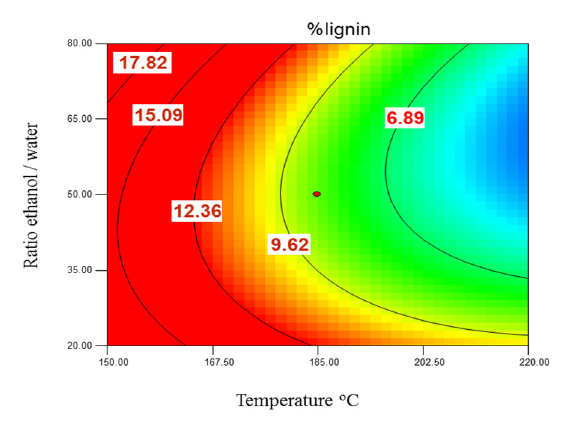
Fig. 4. Effect of temperature and ethanol/ water ratio on lignin percent at constant time 20 min .